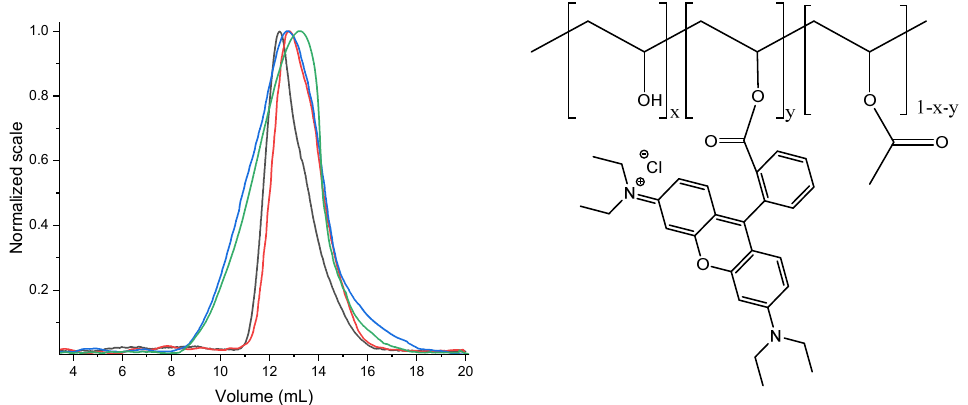
Figure 3. ( Left ) GPC RI detector traces of PVAc (black line), CoVAc-VA (red line), and CoVAc-VA@Rhod (blue line); GPC UV-vis detector trace (set at 554 nm, maximum absorption band of rhodamine B, green line) of CoVAc-VA@Rhod. The CoVAc-VA did not show UV-vis absorption at 550 nm. ( Right ) molecular structure of the CoVAc-VA@Rhod copolymer.